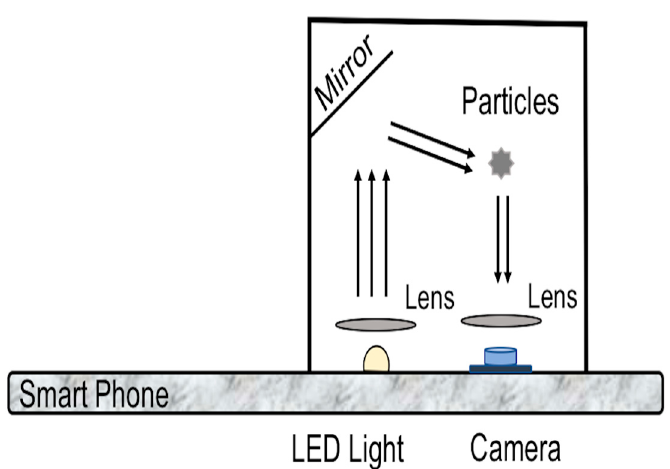
Figure 4. The third-generation design of the optical sensor.